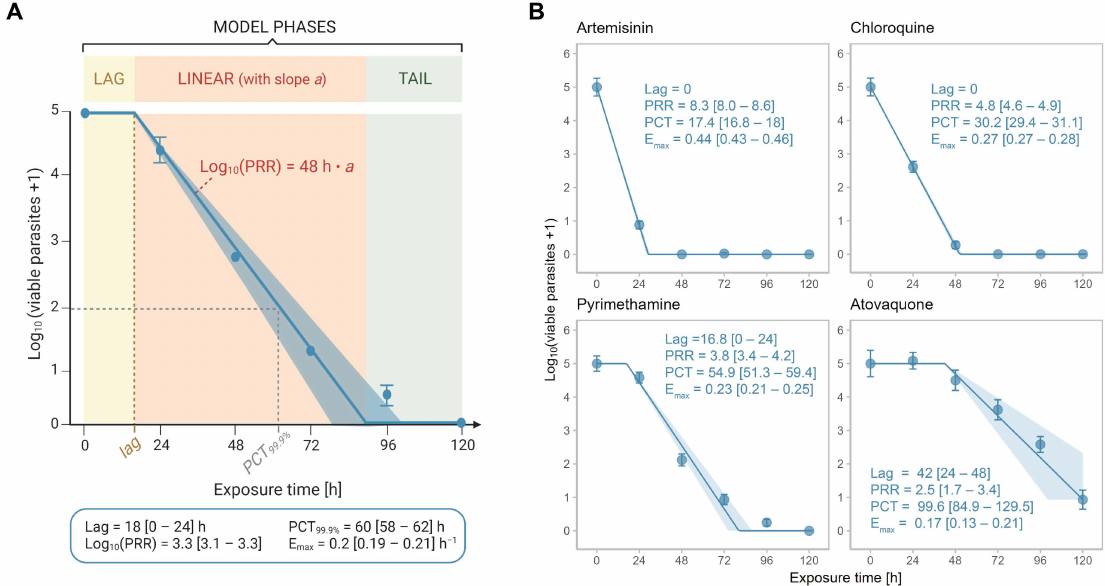
Figure 3. Automated data analysis method. ( A ) Schematic representation of the model. The model considers a lag, linear and tail phase. The lag time (lag) is chosen from a set of potential lags based on the best model fit and marks the end of the lag phase. The slope ‘a’ of the linear phase is used to determine the log 10 (PRR) through multiplying by 48 h. The 99.9% parasite clearance time (PCT 99.9% ) is the time when 99.9% of the parasites are killed, i.e., when the log 10 number of viable parasites is 2. Note that not all killing profiles possess a lag and/or a tail phase. ( B ) Killing profiles and PD parameters for the reference compounds artemisinin, chloroquine, pyrimethamine and atovaquone as determined by the new analysis method of PRR assay V2. Drugs were tested at 10 × IC 50 (or 100 nM for atovaquone in V2) in ≥ three independent experiments. Error bars represent SEM of ≥ four technical replicates and ribbons represent the 95% confidence interval; Lag = lag time (h), PRR = parasite reduction ratio, PCT = 99.9% parasite clearance time (h), E max = maximal killing rate (h − 1 ); square brackets indicate the 24 h range (for lags) or the 95% confidence